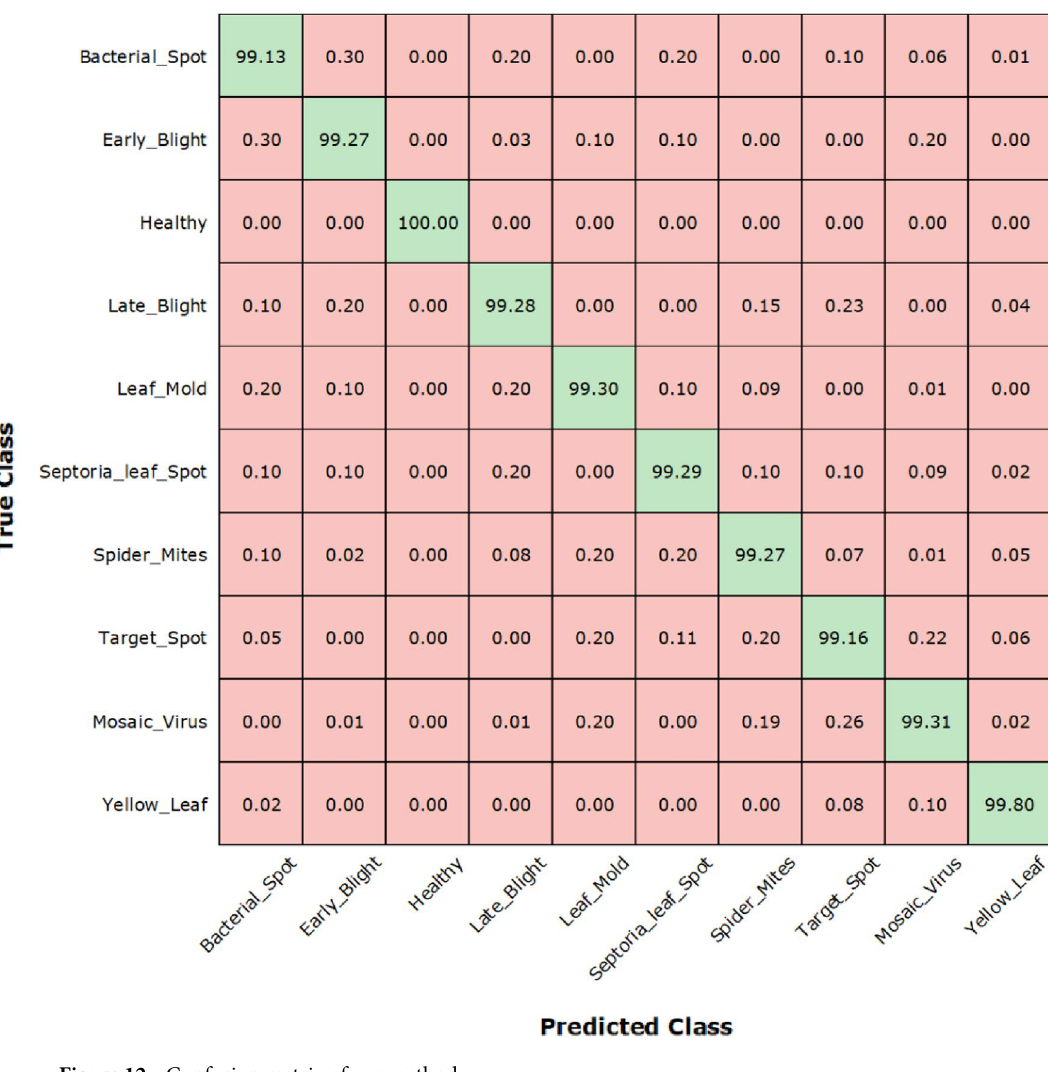
Figure 12. Confusion matrix of our method.